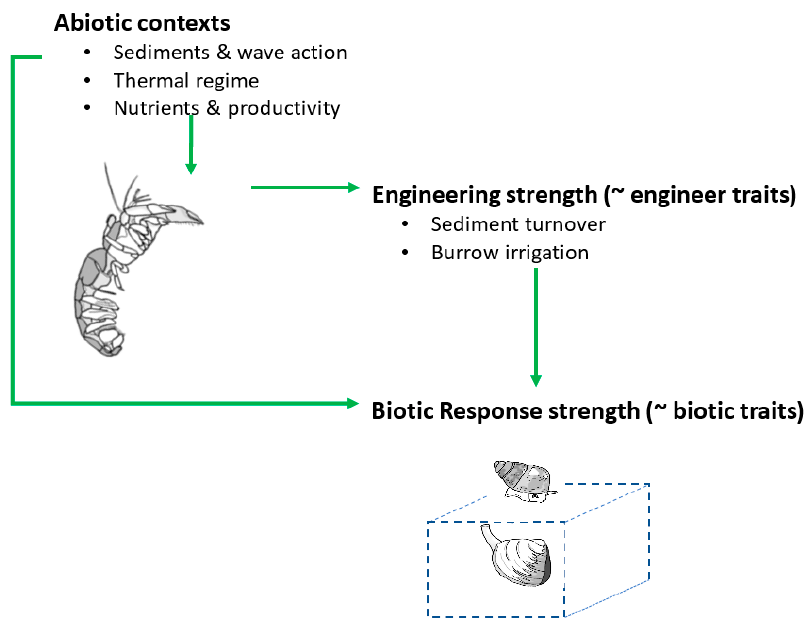
Figure 2. Schematic overview of dependencies that can influence biotic responses to engineering by thalassinidean crustaceans. Abiotic contexts such as sedimentary and thermal regimes influence engineer traits, which in turn determine the strength of abiotic modification, principally by affecting sediment turnover and burrow irrigation. However, fundamental traits of thalassinids determine the degree to which they are influenced by abiotic settings. Community level responses are affected by abiotic contexts and the strength of ecosystem engineering, which are all influenced by biological traits of assemblages. The need to understand and integrate these aspects in future research form the central motivation for this review. Animal drawings courtesy of Jessica Dawson.